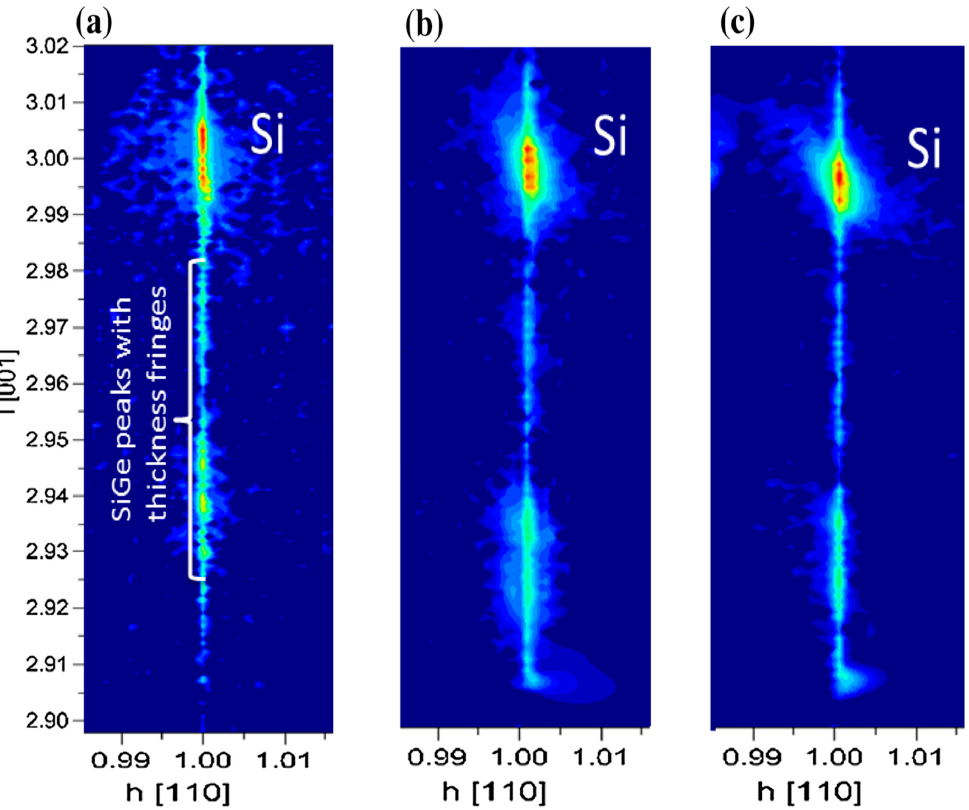
Figure 35. High-reosultion reciprocal lattice maps (HRRLMs) in the vicinity of the asymmetric